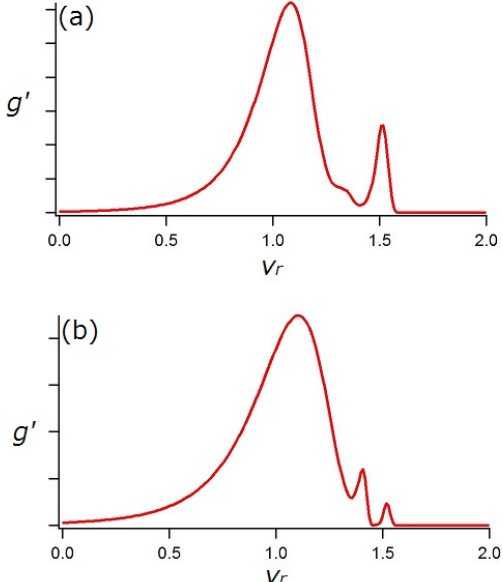
Fig. 6. The snapshot of (a) the transverse magnetic field and (b) g 0 at t = 22 . 0 in Run